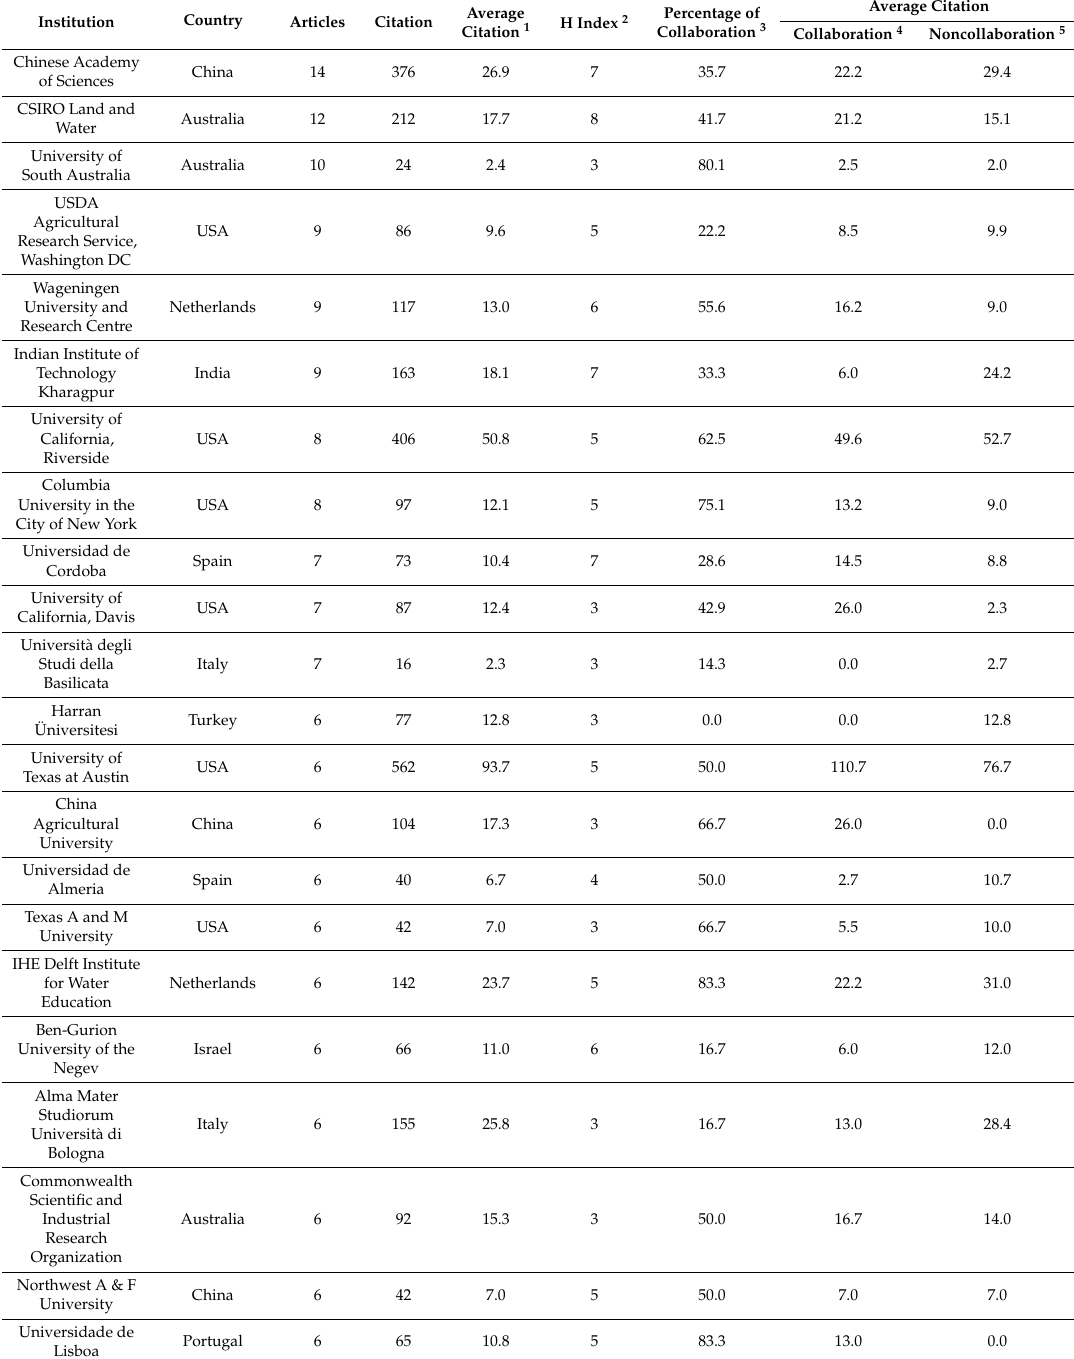
Table 6. Main characteristics of the most active institutions related to SI